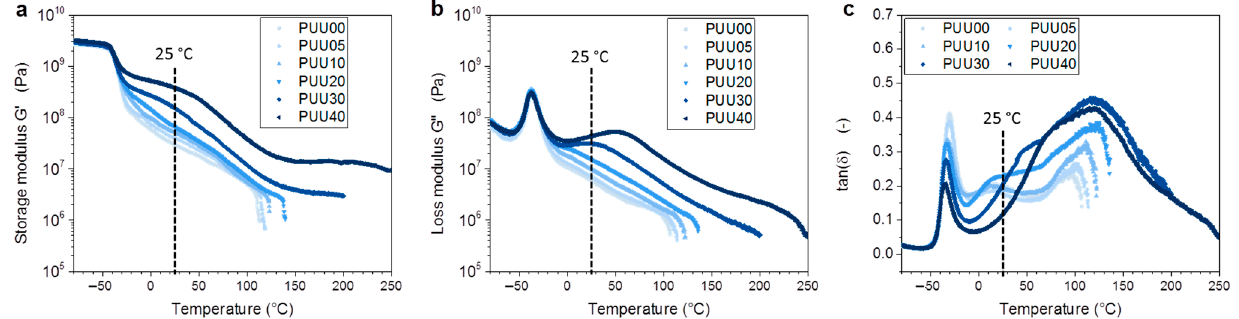
Figure 2. DMTA curves for PUU/nanosilica composites. The curves show the temperature-depend- ent ( a ) storage modulus, ( b ) loss modulus, and ( c ) damping factor for all investigated filler concentrations.